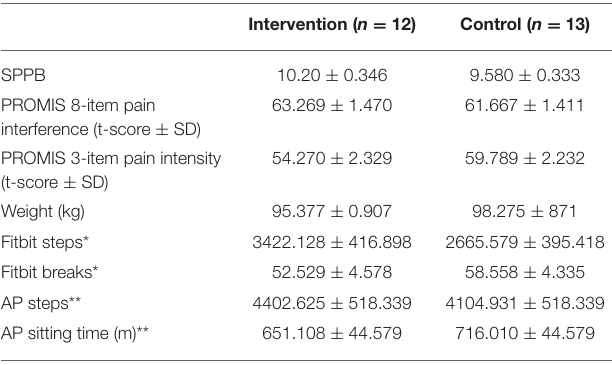
Frontiers in Digital Health |